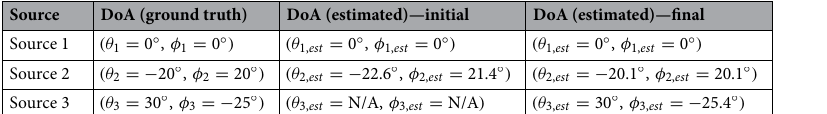
Source DoA (ground truth) DoA (estimated)—initial DoA